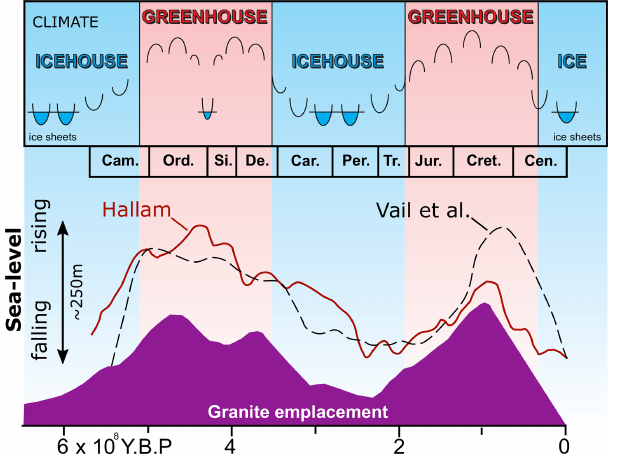
Figure 10. Cyclic outlines of Phanerozoic history (modified from Fischer, 1981, 1982). Climatic oscillations are composed of green- house and icehouse states, with minor internal climatic fluctuations. Sea-level curves, according to Vail et al. (1977) and Hallam (1977). Global granite emplacement was deduced from data based on the American granite emplacements (after Engel and Engel,